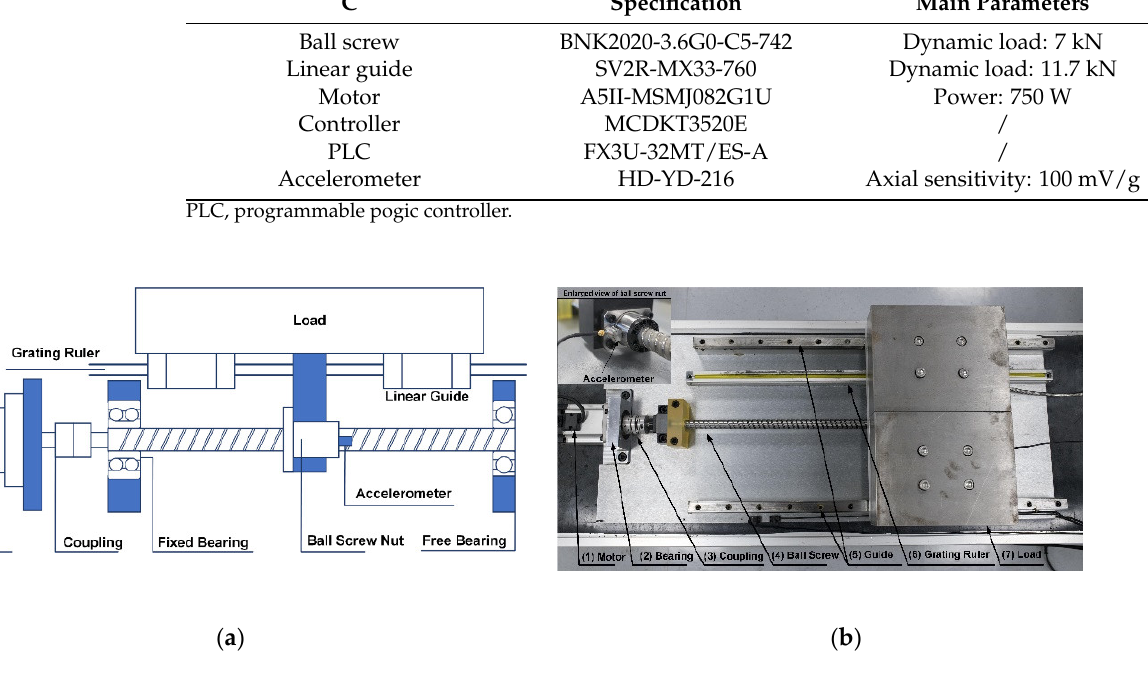
Figure 13. ( a ) Schematic of the ball screw test platform. ( b ) Photograph of the ball screw test platform.